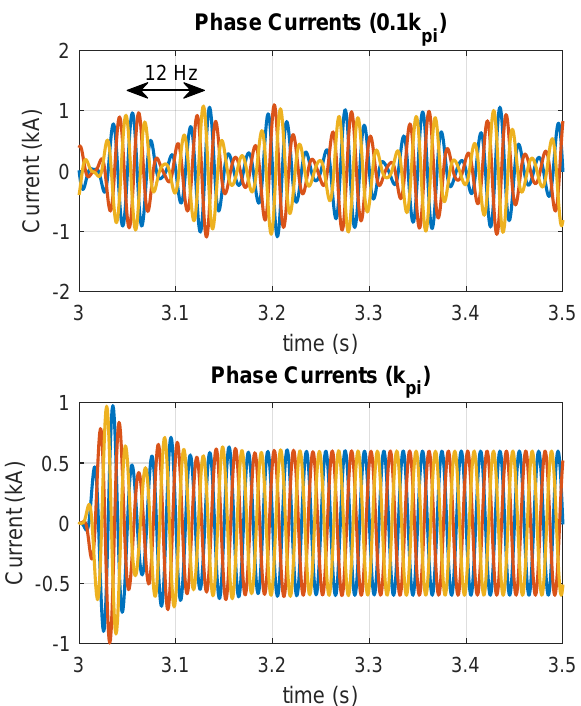
Figure 17. ( Top plot ) time domain plot of phase currents in abc frame, for the case with 0.1 × k pi showing resonances at around 12 Hz; ( Bottom plot ) base case with k pi